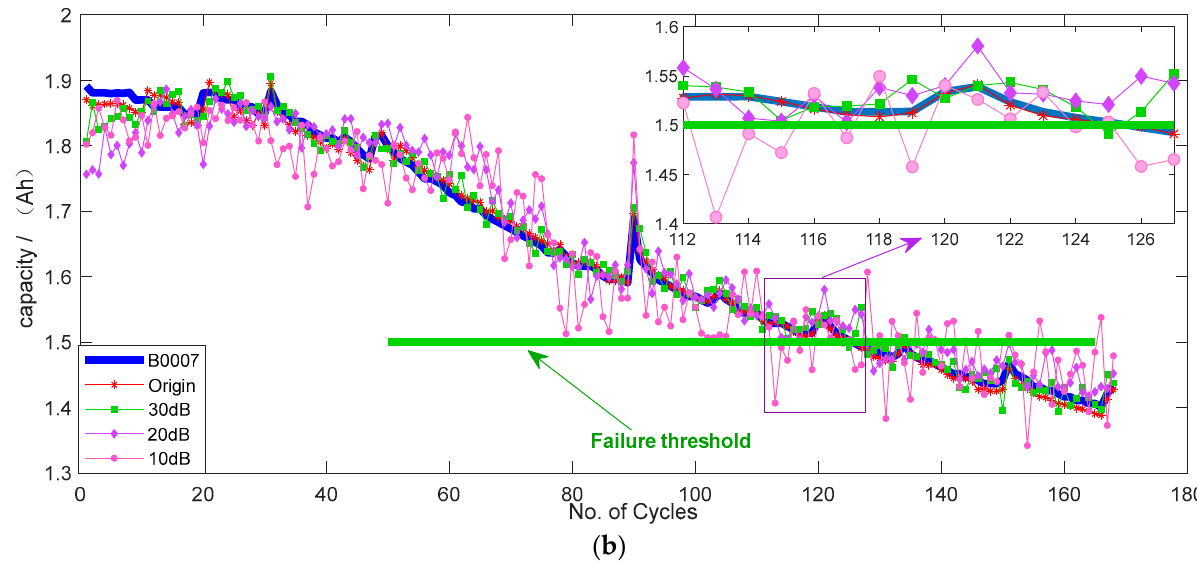
Figure 10. Prediction results of LAOS-XGboost model after adding noise. ( a ) SOH prediction re- sults of B0006 battery. ( b ) SOH prediction results of B0007 battery. of B0006 battery. ( b ) SOH prediction results of B0007 battery. The detailed indicators of the model are shown in Table 3. The detailed indicators of the model are shown in Table 3. Table 3. Detailed prediction results of various Table 3. Detailed prediction results of various models.